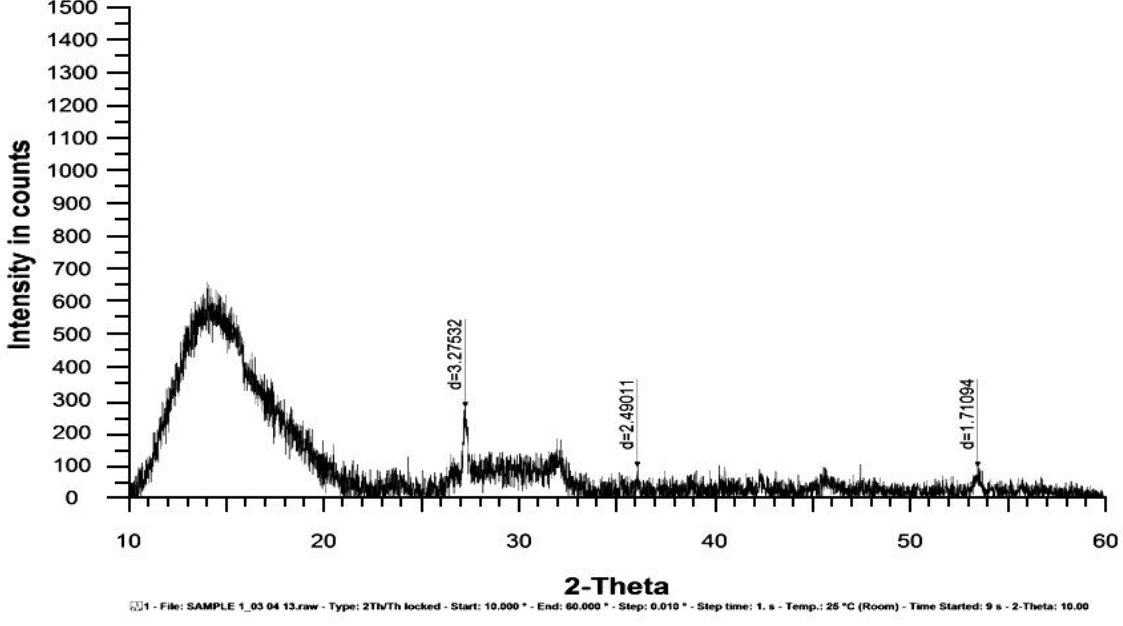
Figure 4: X-ray diffraction pattern of AgNPs synthesized by marine seaweed Sargassum